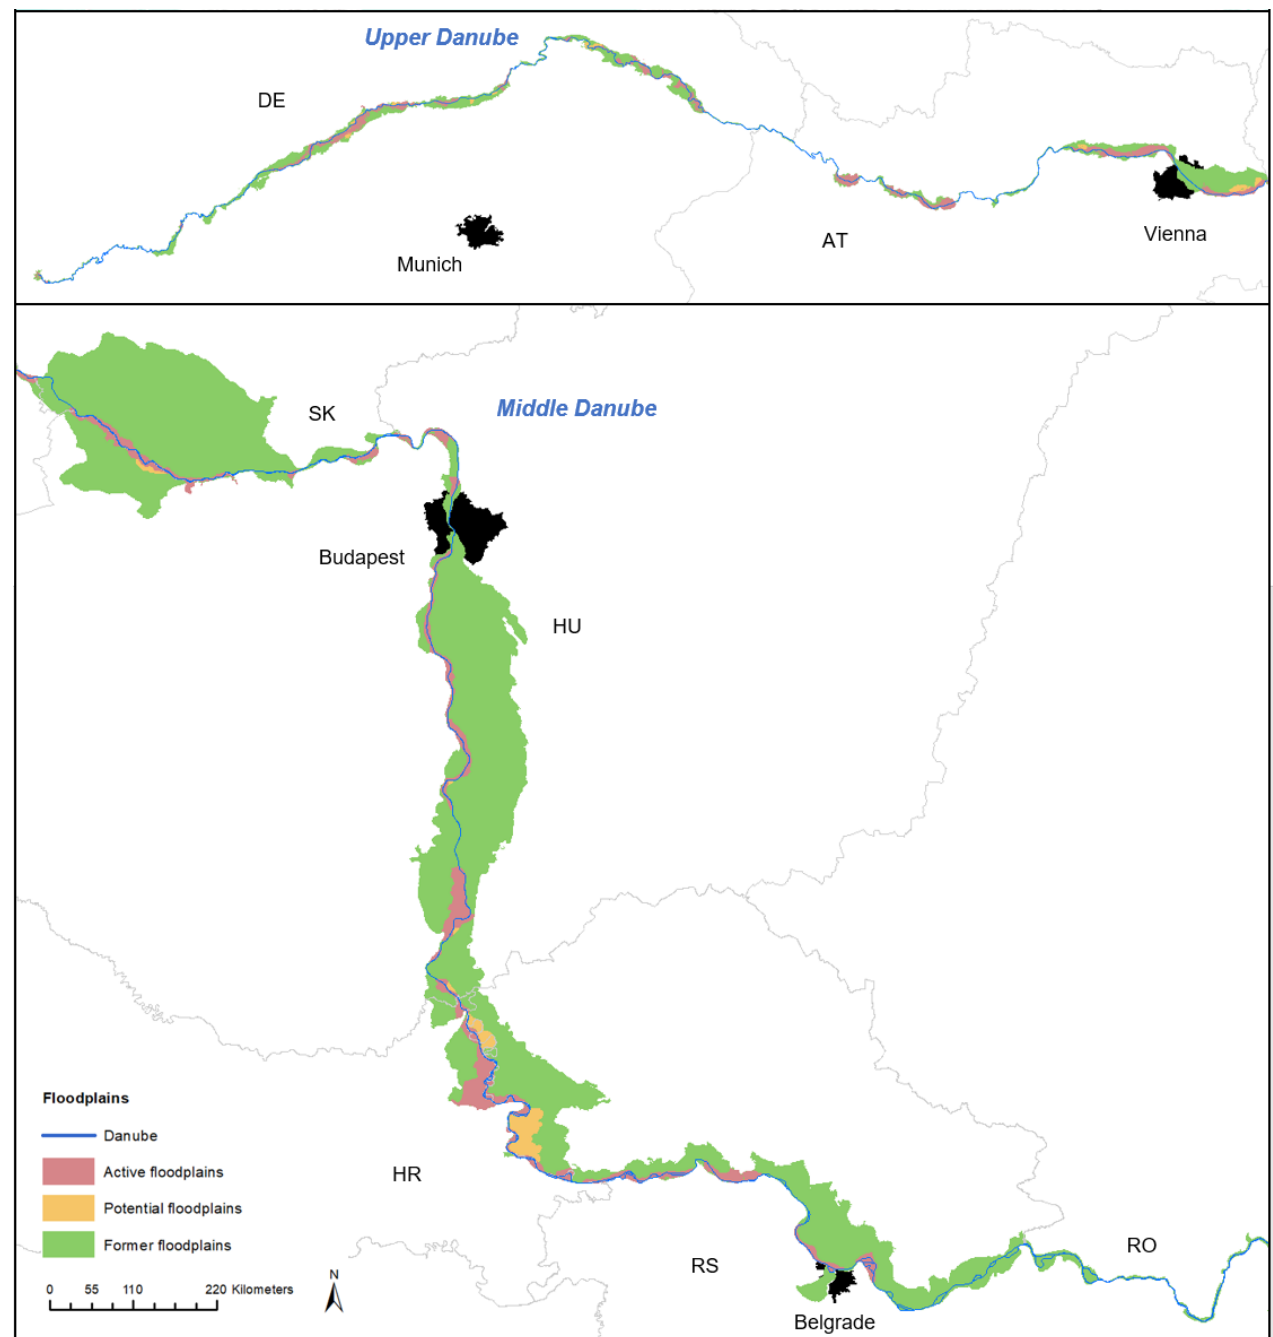
Figure 4. Overview of the active, former, and potential floodplains at the Upper and Middle Danube.